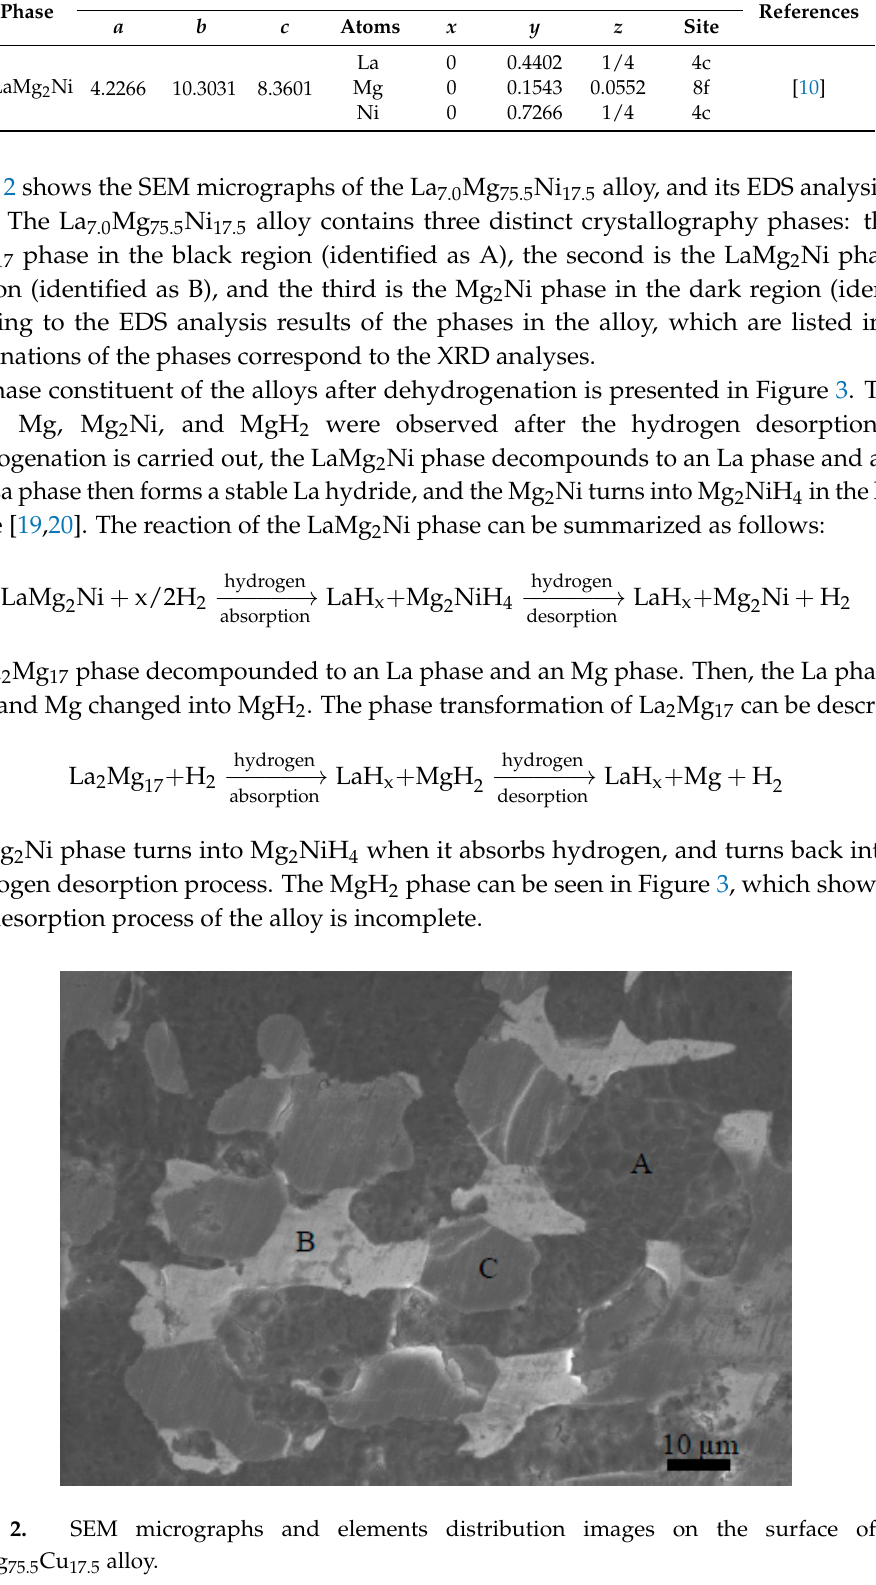
Table 1. X-ray structure refinement results on a single crystal of LaMg 2 Ni.